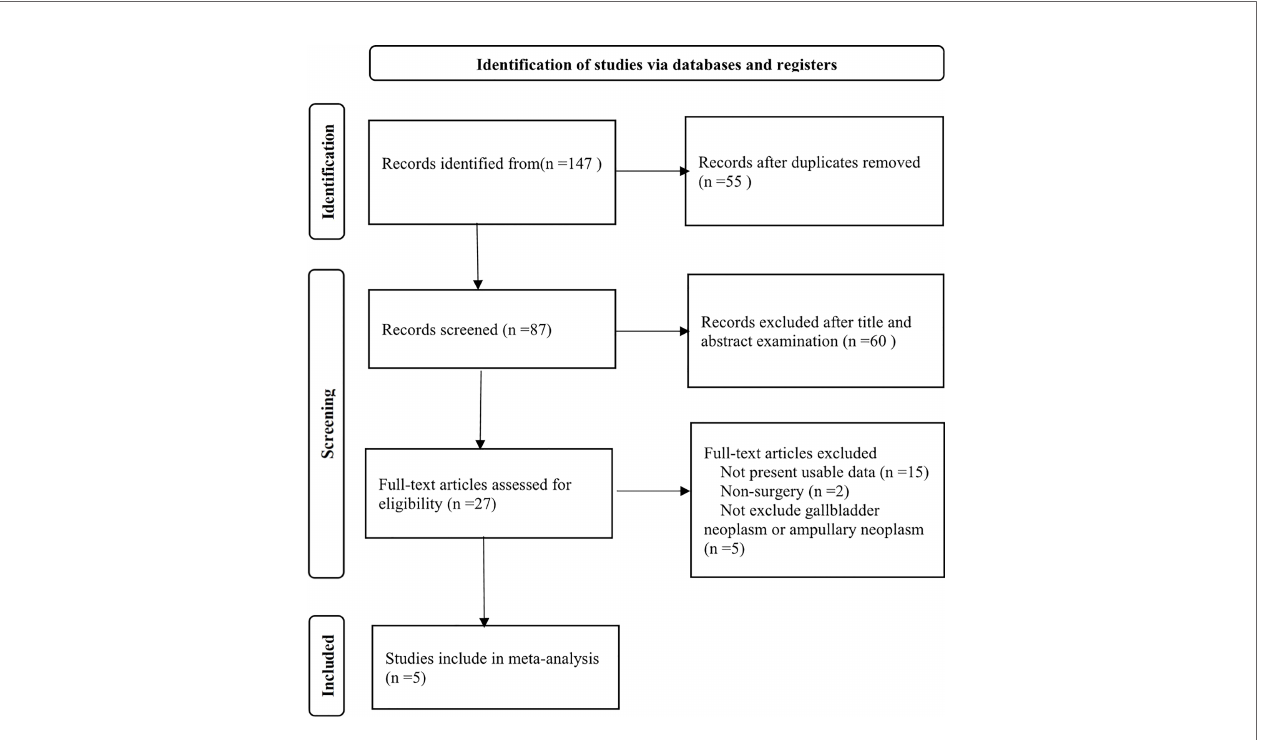
FIGURE 1 | Flow diagram of study selection in the meta-analysis.